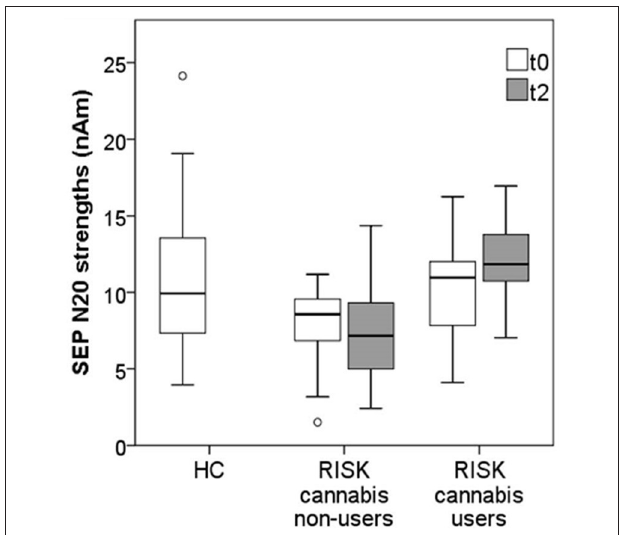
FIGURE 2 | Mean N20 strengths in cannabis non-users ( n = 19) vs. cannabis users ( n = 8) from the RISK group at baseline (t0) and at follow-up (t2), compared to the reference values from the HC group ( n = 35).